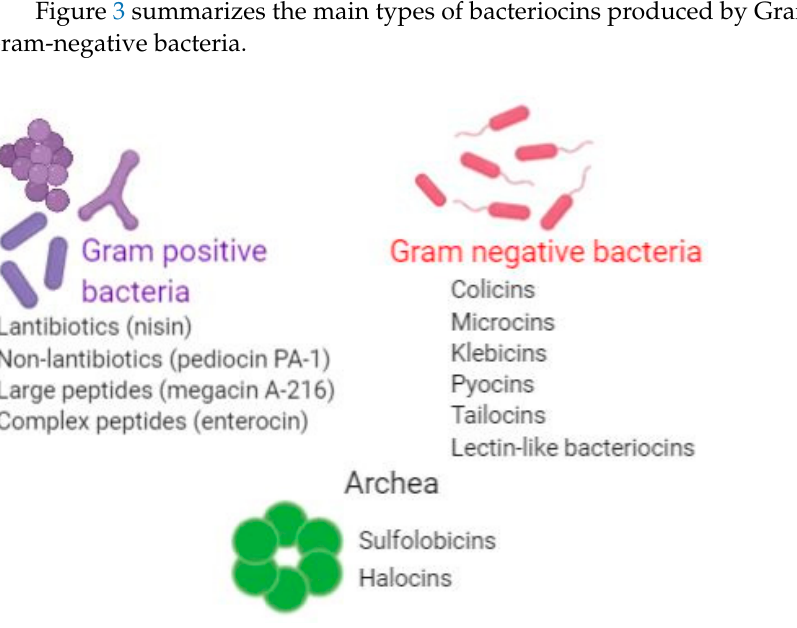
Figure 3. Main examples of bacteriocins produces by Gram-positive and Gram-negative bacteria as well as those produced by Archaea (original figure, made using biorender.com).